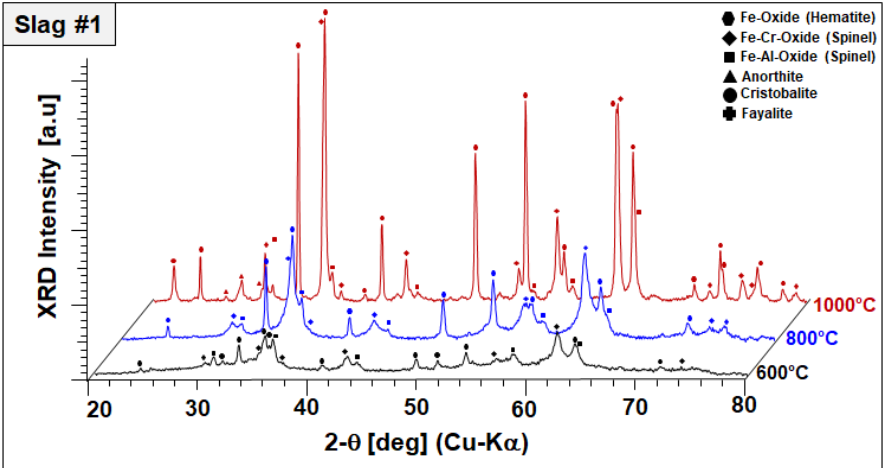
Figure 5. XRD profiles and co-existing crystalline phases of slag 1 after annealing for 2 h in air.